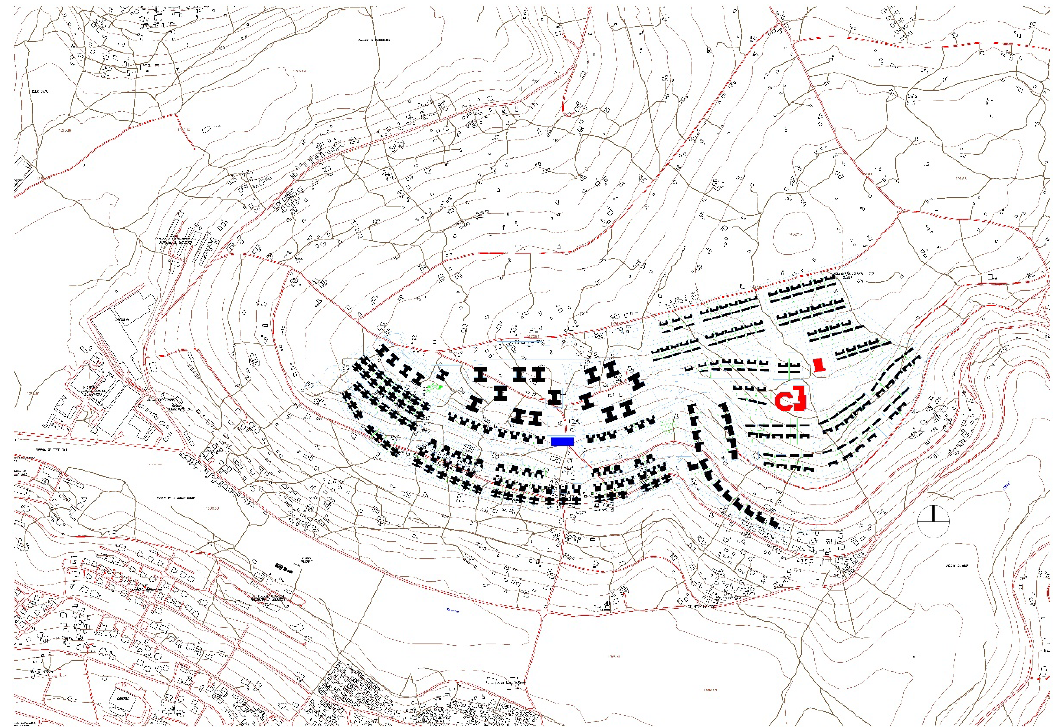
Figure 27. The Gacuriro Valley Satellite over the original situation. Drawing by Manlio Michieletto. Gacuriro is an area located in the north-east part of the Rwandan Capital that was previously devoted to agricul- ture and scattered houses (again, see Figure 3).